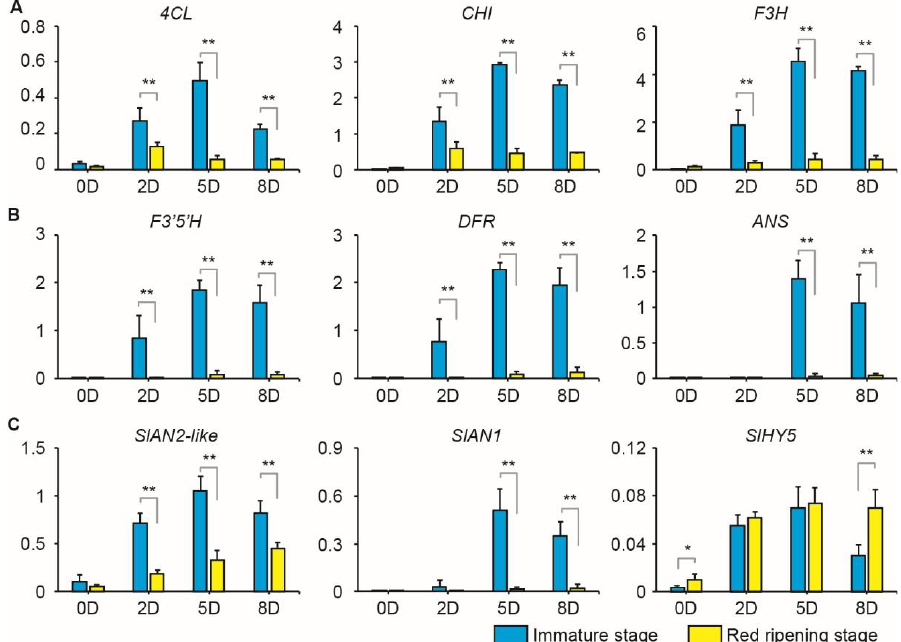
Figure 3. Transcriptional analysis of anthocyanin-related genes in immature and red ripening fruits before and after removing bags. Transcriptional analysis of the EBGs ( A ), LBGs ( B ), and transcription factors ( C ) using qRT-PCR. ACTIN was the reference gene. Data are presented as mean ± SD of three biological replicates. Asterisks indicate significant differences between immature and red ripening fruits, determined by the Student’s t -test (* p < 0.05, ** p < 0.01). As with the structure genes, the key anthocyanin activators, SlAN2-like and SlAN1 , increased quickly in immature fruits after bag removal (Figure 3C), but differed from the